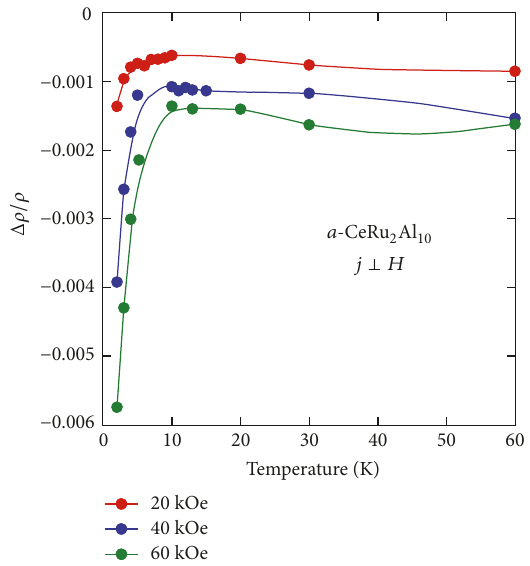
Figure 6: Temperature dependence of the magnetoresistance Δ𝜌/𝜌 under various magnetic fields for a -CeRu 2 Al 10